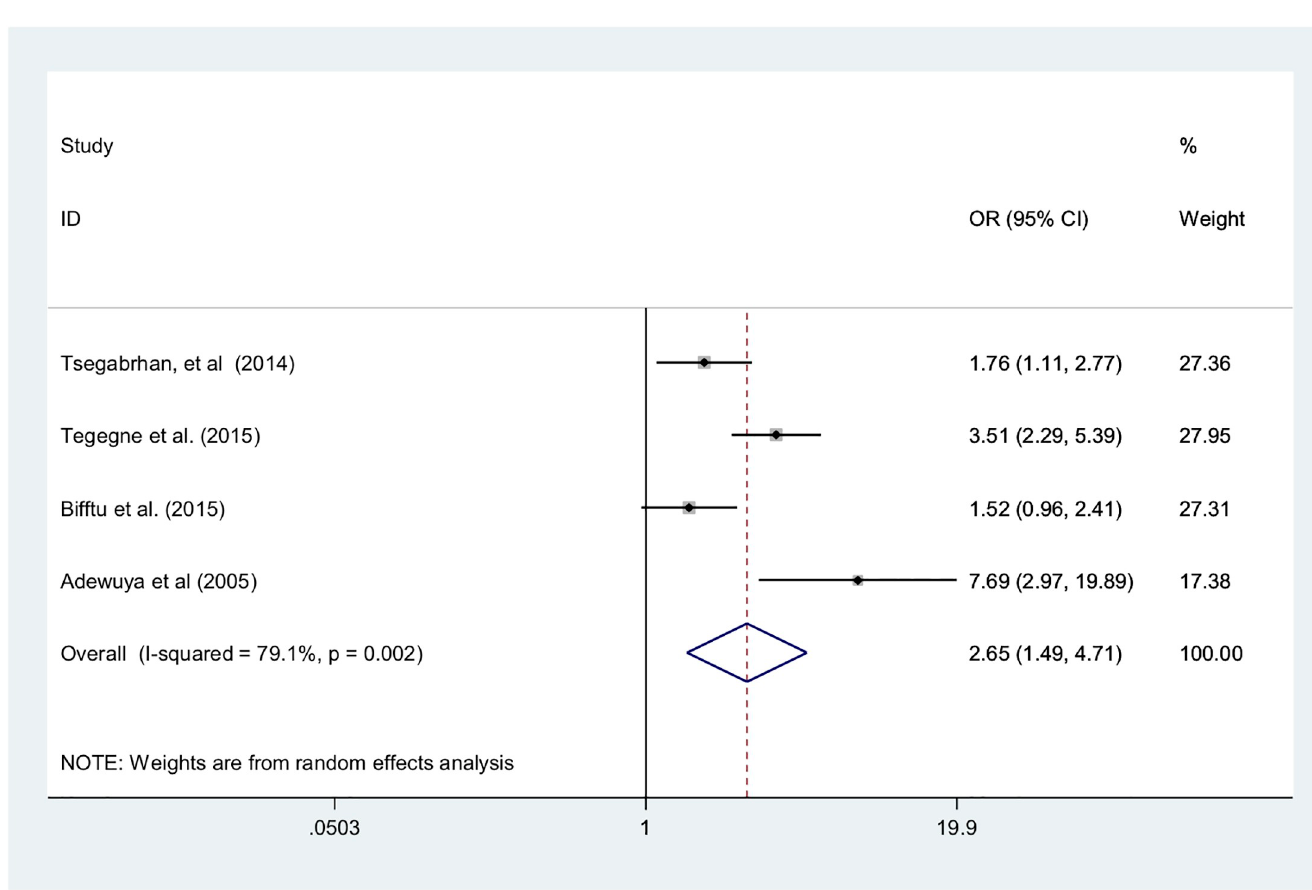
Fig 4. Forest plot of four studies examining the association of polytherapy with depression among epilepsy patients, 2005–2017, sub-Saharan Africa.